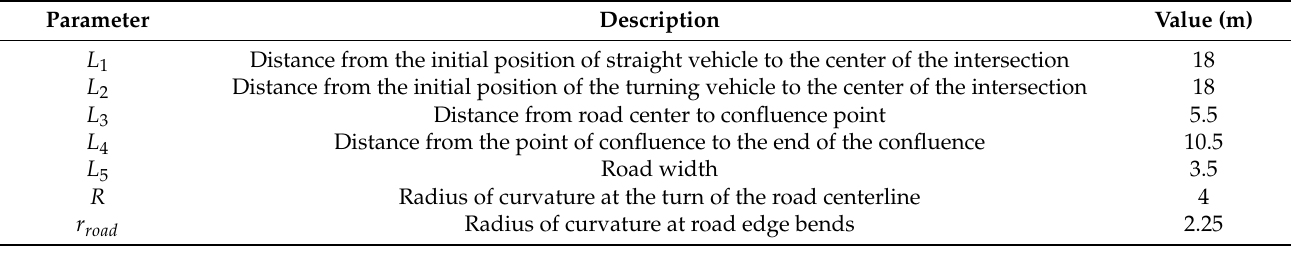
Figure 14. Scenario model in cosimulation. Table 2. Road model parameters in cosimulation.